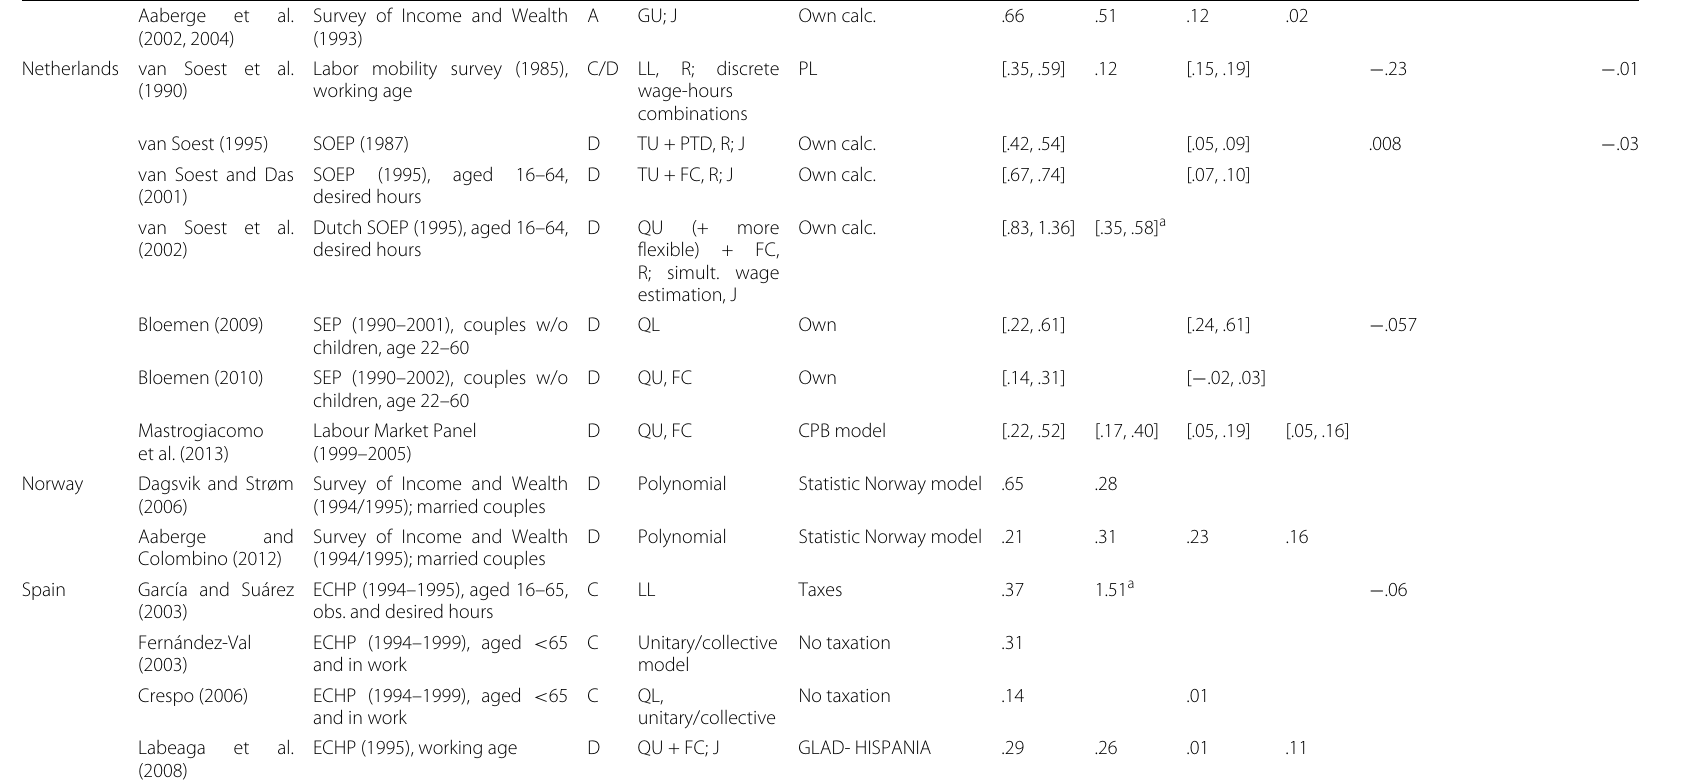
Table 1 Labor supply elasticities in Europe: couples